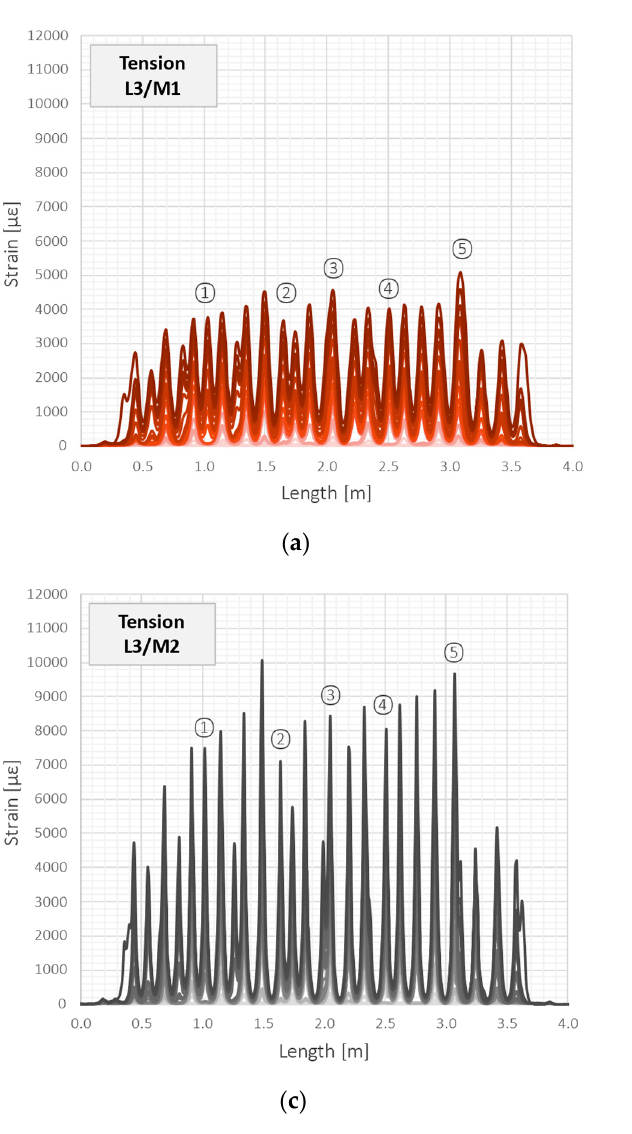
stdv L —standard deviation of strains over the length (µ ε ); sr —spatial resolution (equal to